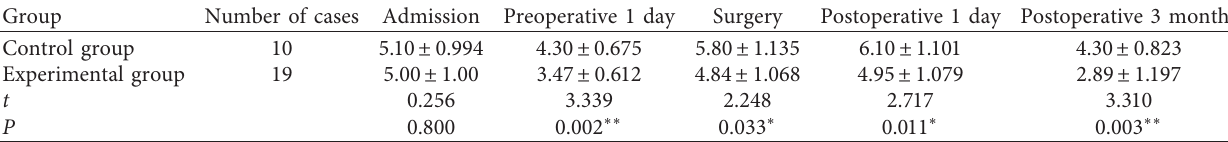
Table 2: Comparison of pain scores between the two groups (NRS) ( x ± s ).